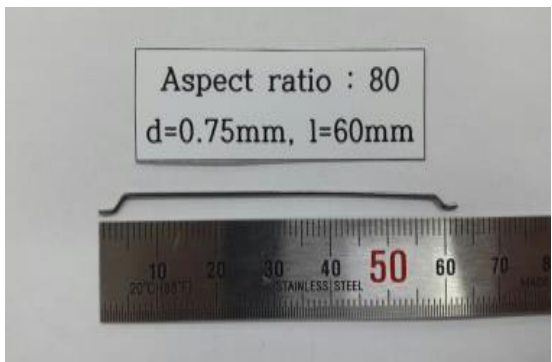
Figure 1. The shape of the used steel fiber.